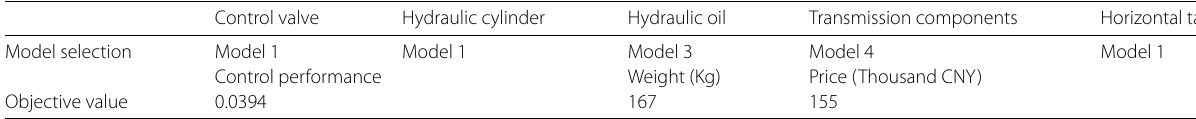
Table 2 Details of the “most preferred” design